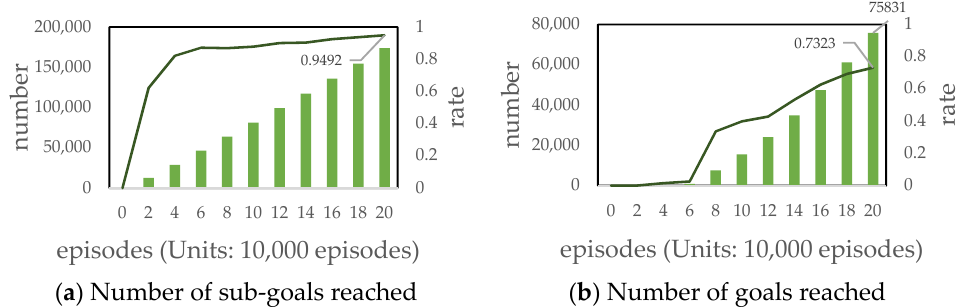
Figure 9. Cumulative number of sub-goals and goals reached by the traditional double layered A3C: ( a ) number of sub-goals reached and ( b ) number of goals reached. The x -axis is number of episodes (units: 10,000 episodes), the left y -axis is number of sub-goals/goals reached, and the right y -axis is reach rate.